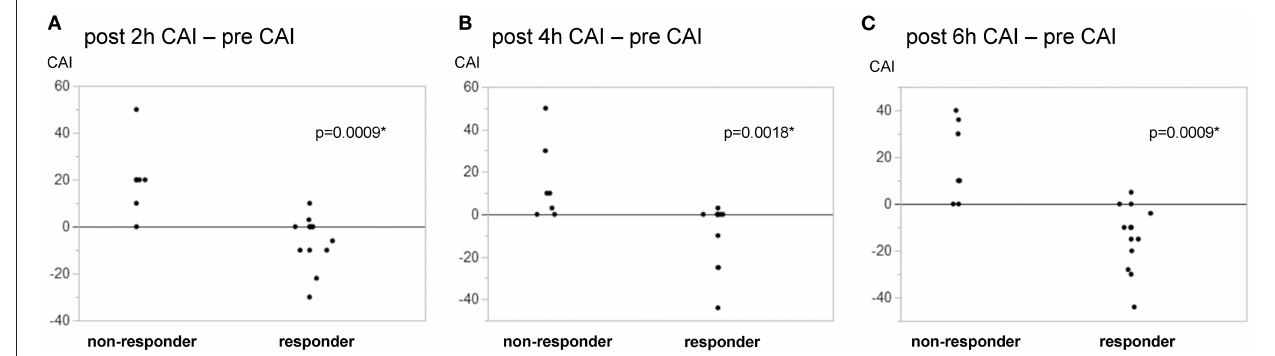
FIGURE 2 | Changes in the catecholamine index in responders/non-responders to vasopressin loading. Responders to vasopressin loading were defined by a MAP change ≥ 18 mmHg from before to 1min after loading. Fourteen responders (66.7%) and 7 non-responders were identified. A change was observed in the catecholamine index (CAI) [dopamine + dobutamine + (noradrenaline + adrenaline) × 100 µ g/kg/min] from pre-loading to 2, 4, and 6h after the initiation of vasopressin. (A) post 2-h—pre. (B) post 4-h—pre. (C) post–pre. Changes in CAI significantly differed between responders and non-responders at 2, 4, and 6h. * p <